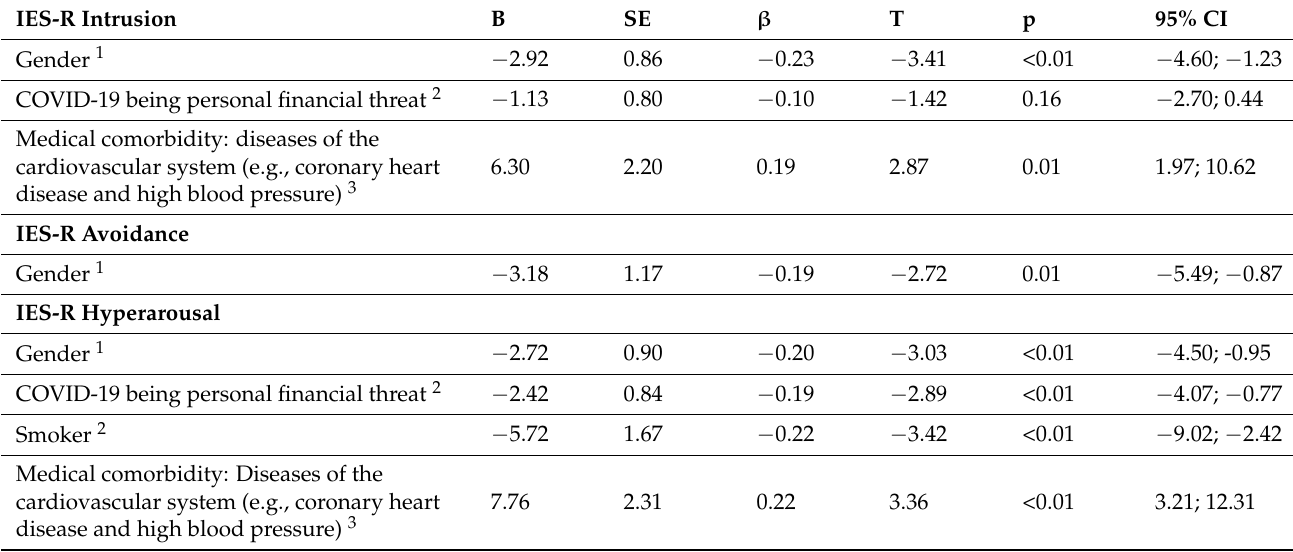
Table 7. Multiple regression analyses with relevant factors of IES-R